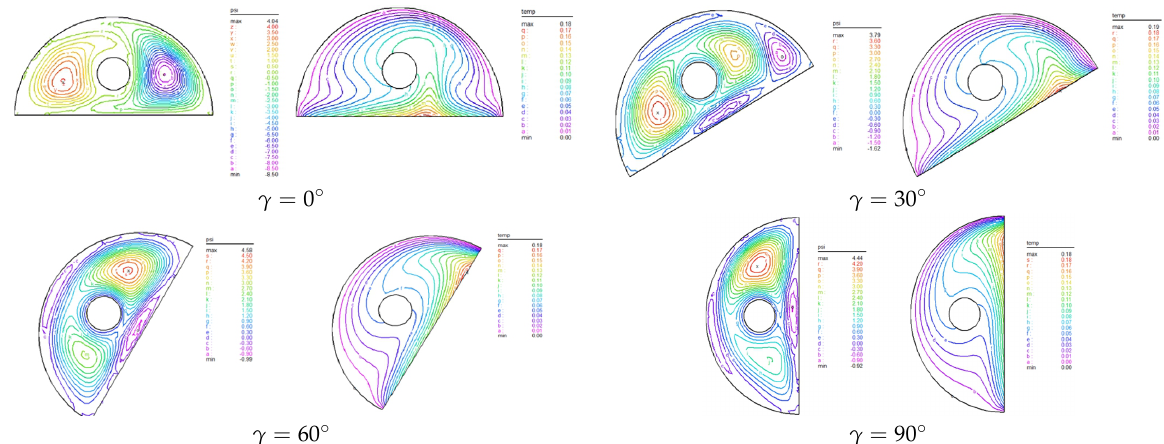
Fig. 5. Streamlines and isotherms for Ω = 1000, C = 0.2, and Ra = 10